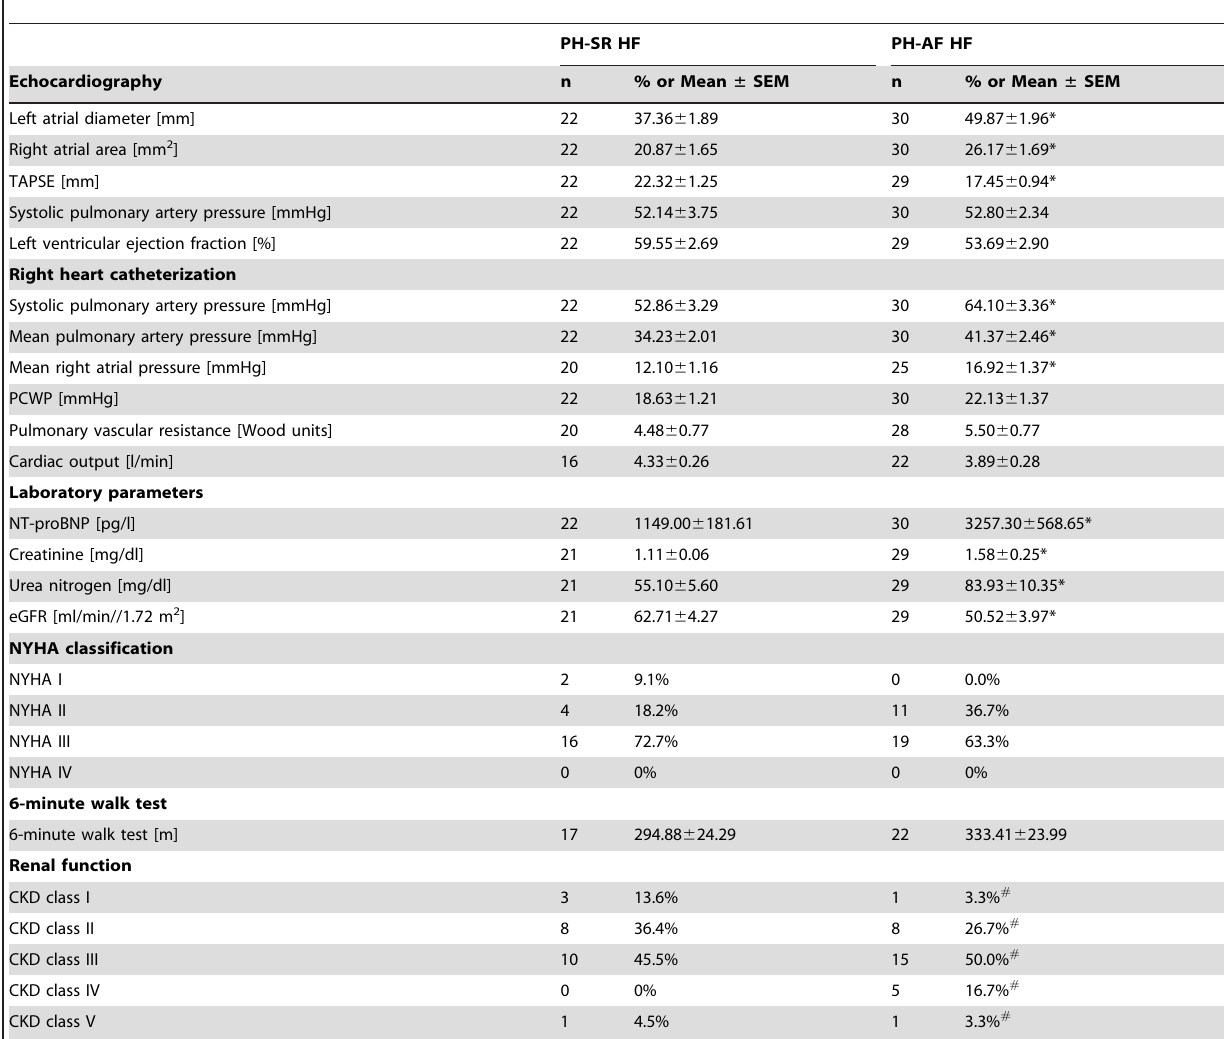
Table 6. Comparison of subgroups with SR vs. AF in PH related to left heart disease